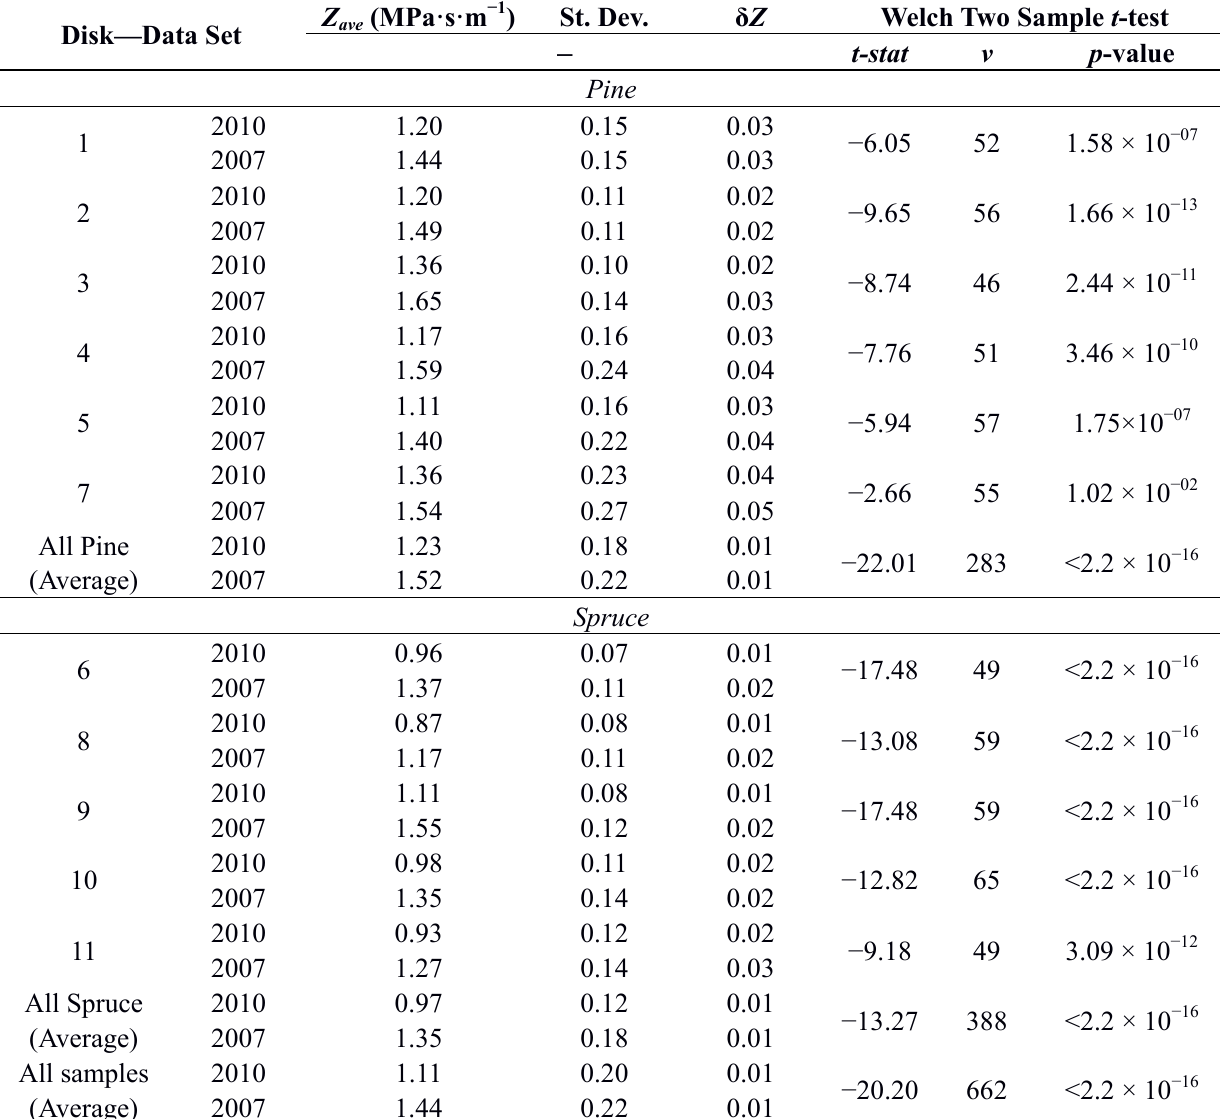
Table 4. Results for characteristic impedance